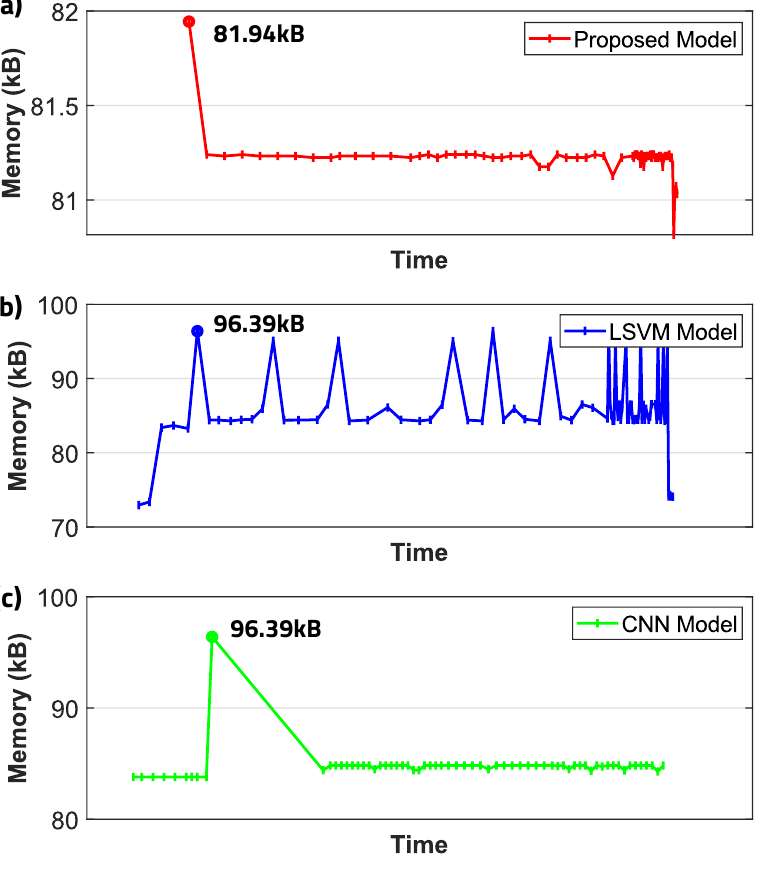
Figure 15. ( a ) Memory usage of the proposed model. ( b ) Memory usage of the LSVM model. ( c ) Memory usage of the CNN